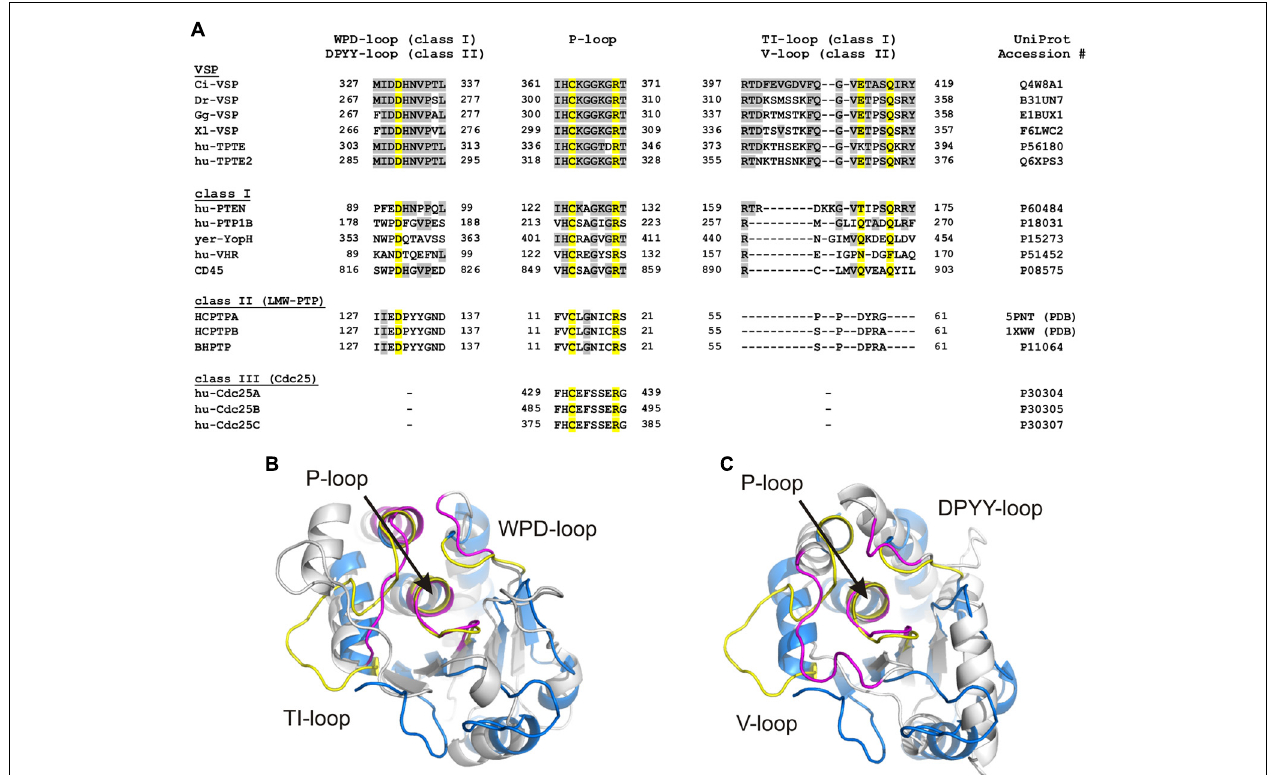
FIGURE 3 | Loop regions determine the conformation of the substrate binding pocket in cysteine-based PTPs. (A) Sequence alignment of the three loops which specify the conformation of the substrate binding pocket. The P-loop contains the highly conserved CX 5 R motif that serves as active site. The WPD-/DPYY- and the TI-/V-loops form the side walls of the substrate binding pocket in class I and II PTPs. Because class III PTPs lack the two latter loops, no sequence alignment could be performed for these regions. Amino acids identified as identical to Ci-VSP are marked in gray. Yellow colored residues are crucial for catalysis and widely conserved among PTPs. UniProt accession numbers are indicated for all sequences